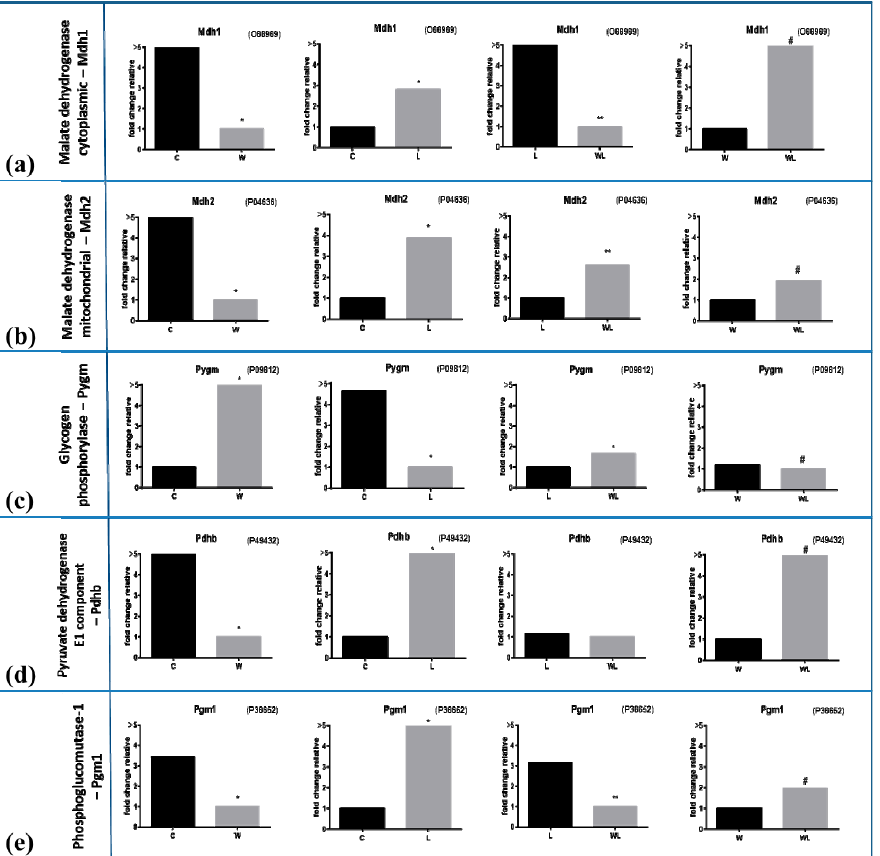
Figure 5. Muscle proteomic profile in all experimental groups subject or not to leucine-rich diet and bearing or not Walker-256 tumour. ( a ) malate dehydrogenase cytoplasmic—Mdh1, accession code O88989 and ( b ) malate dehydrogenase mitochondrial—Mdh2, accession code P04636 in gastrocnemius muscle under effects of Walker-tumour development and nutritional supplementation with leucine. ( c ) Glycogen phosphorylase—Pygm, accession code P09812 and ( d ) Pyruvate dehydrogenase E1 component—Pdhb, accession code P49432 in gastrocnemius muscle. ( e ) Phosphoglucomutase-1—Pgm1, accession code P38652 in gastrocnemius muscle. The values are expressed as the difference of maximal fold change. Legend: C, control group; W, Walker tumour-bearing group; L, rats fed a leucine-rich diet; WL, tumour-bearing rats fed a leucine-rich diet. * p < 0.05 difference against C group; ** p < 0.05 difference against L group: # p < 0.05 difference against WF group.